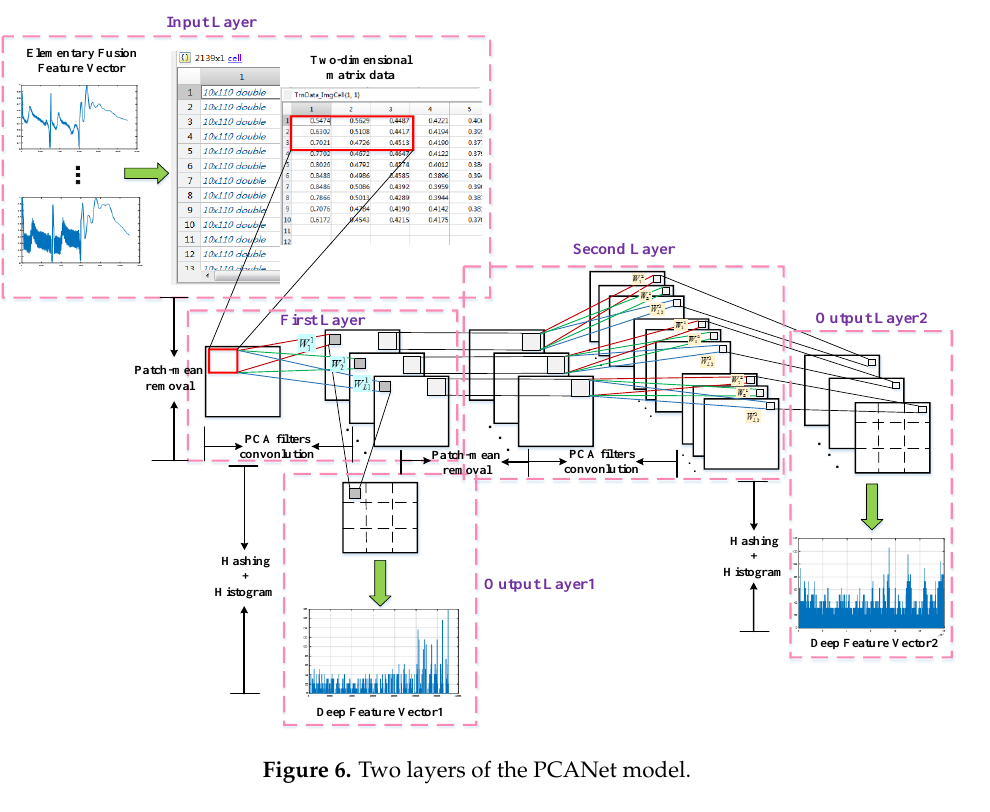
Figure 6. Two layers of the PCANet model.